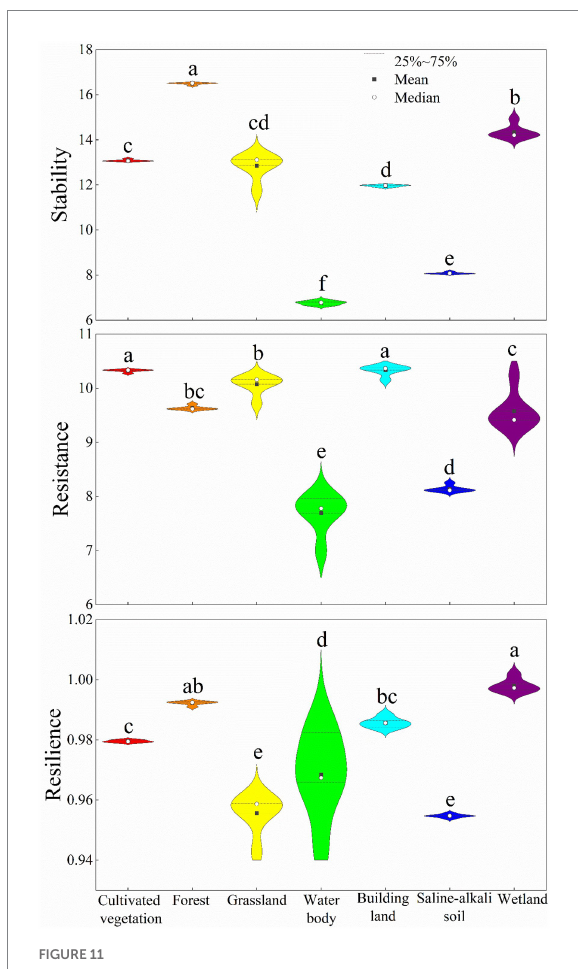
FIGURE 11 Comparison of the vegetation stability, resistance, and resilience among the different vegetation types. Different lowercase letters indicate the statistical differences, p <